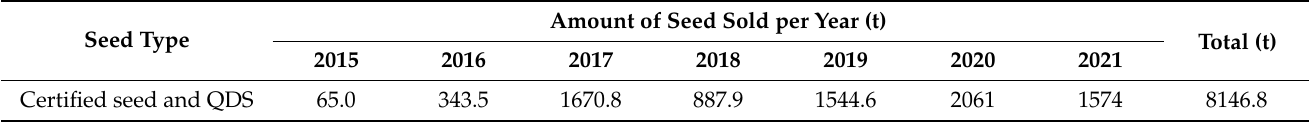
Table 7. Amount of seed sold in small packs in 2015–2021.